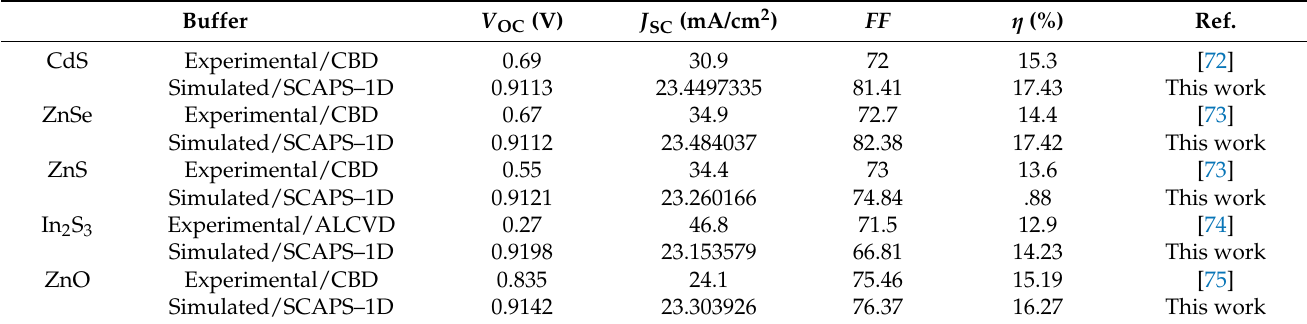
Table 7. Comparison of functional parameters with experimental